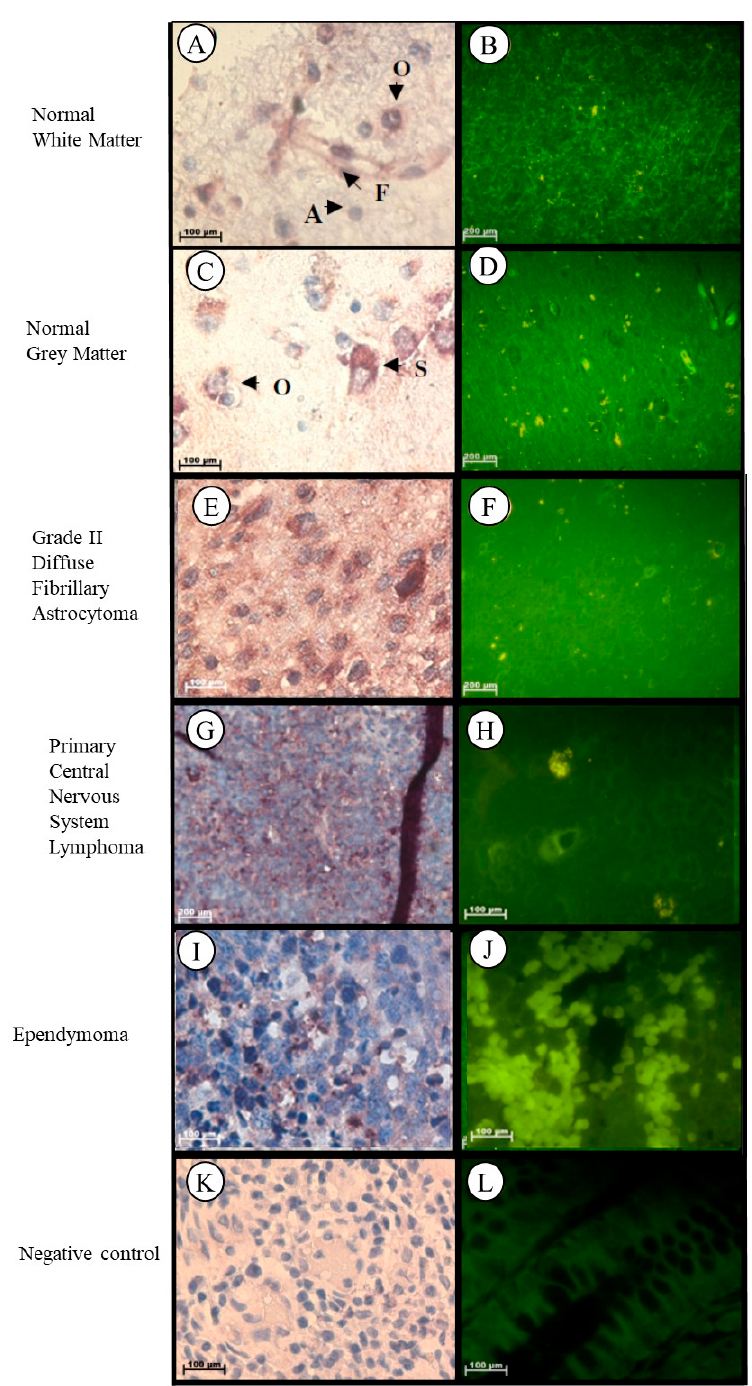
Figure 8. Subcellular Localisation of Tspo mRNA in healthy and diseased Brain Tissue. Tspo mRNA transcription occurs in both white ( A , B ) and grey ( C , D ) matter. Where it is found in astrocytes (A), fusiform cells (F), oligodendrocytes (O), and stellate cells (S). A comparison of the fluorescent intensity between normal ( B , D ) and cancer ( D , F , H , I ) tissue shows that Tspo transcription levels are highest in cancer tissues. Tspo mRNA is found in Grade II diffuse fibrillary astrocytoma ( E , F ), primary central nervous system lymphoma (PCNSL) ( G , H ) and ependymoma ( I , J ). Negative control for the subcellular localisation of Tspo mRNA ( K , L ). Sense probes were used to probe tissue preparations and this was analysed colorimetrically and fluorescently. Tissues are magnified at 1000×.